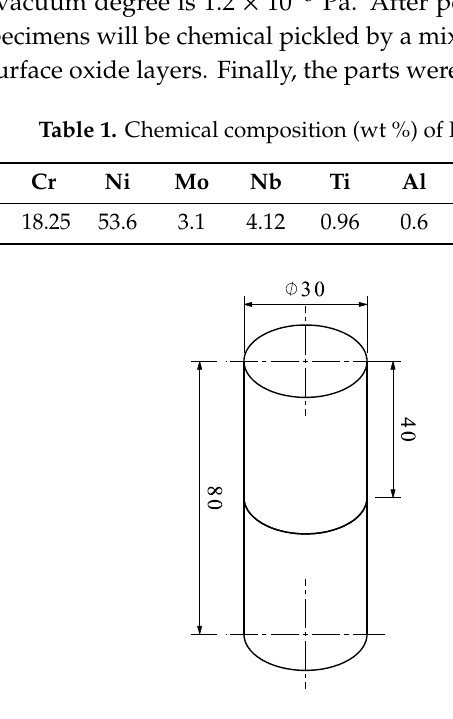
Figure 1. Schematic diagram of bonding structure (unit: mm).